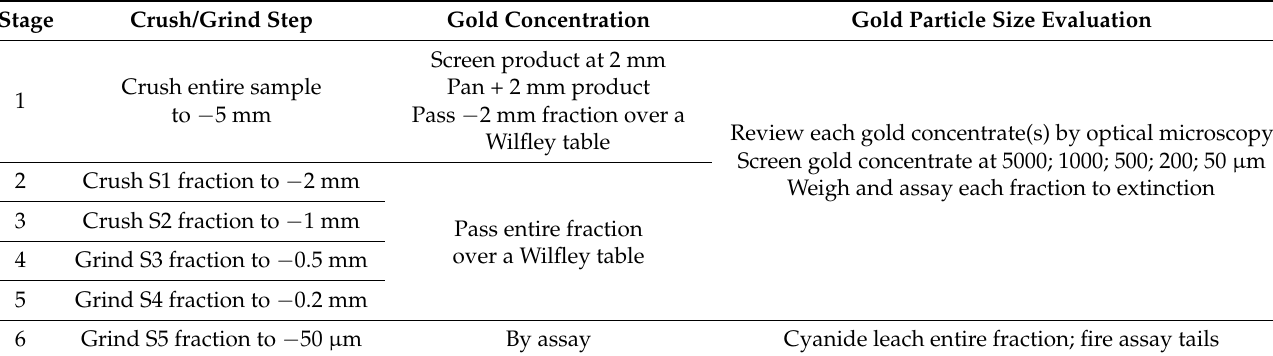
Table 8. Overview of the metallurgical testwork protocol enacted for MET samples 2 to 5.